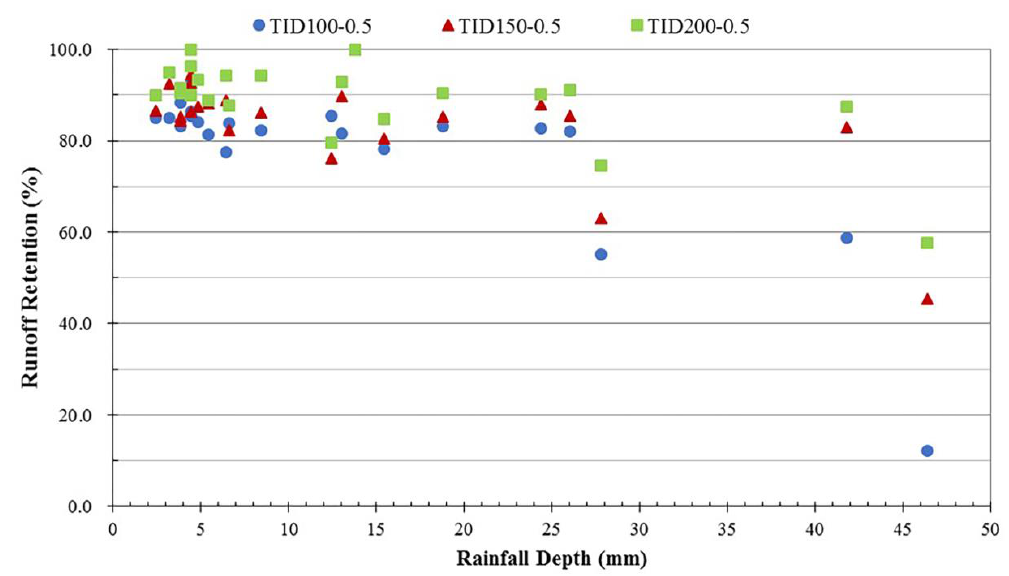
Figure 5. Rainfall retention rates R3 varying with different substrate depths of EGR modules under 22 monitored rainfall events.